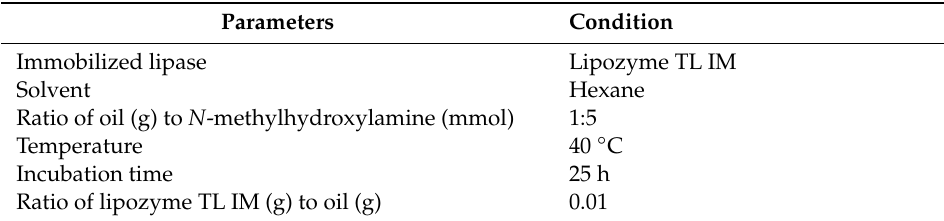
Table 1. Reaction parameters of synthesis of